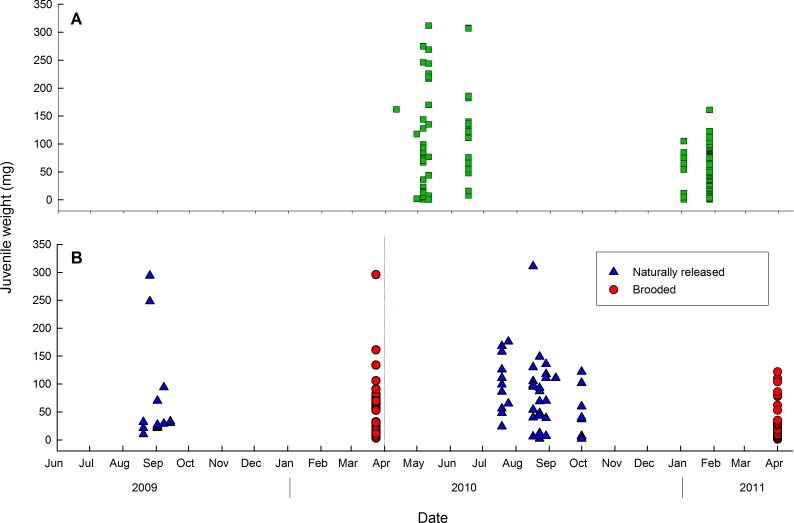
Distribution of juvenile sizes (wet weight) over time in Aulactinia stella.(A) Juveniles extracted from the gastrovascular cavity immediately after collection of brooding adult. (B) Naturally-released juveniles and brooded juveniles in two experimental periods from 2009 to 2011. Dashed line separates the two experimental periods.